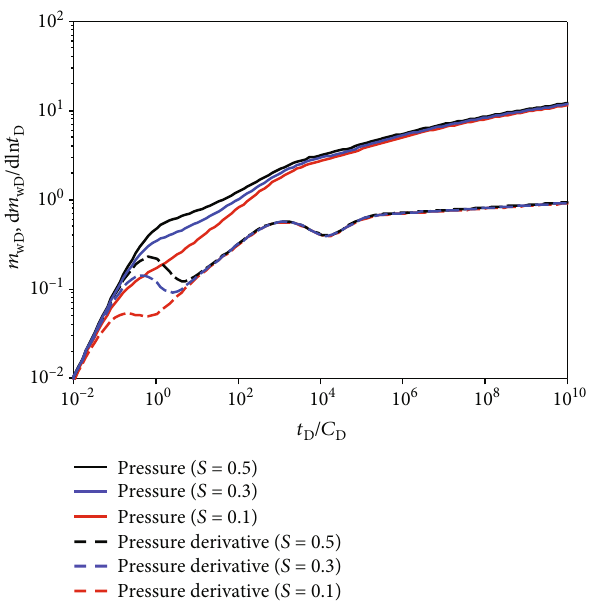
Figure 9: E ff ect of skin factor, S , on type